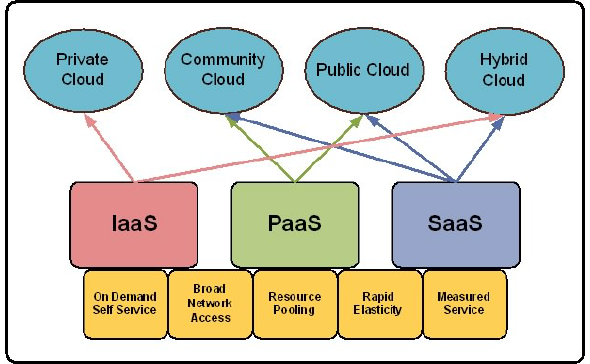
Figure 1. Cloud deployment models and